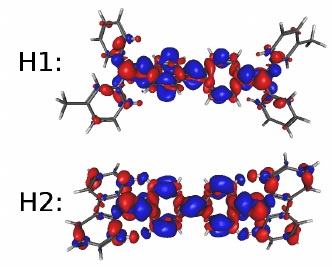
Figure 6. Iso-contour plots (cutoff value of 0.001 au.) of ground- and the first excited-state density difference for the hole-acceptor systems H1 and H2. Table 5. Charge-transfer parameters computed using the density for the main excited state (second column) of each molecule here considered (first column). Units used for the calculated magnitudes are given in parenthesis. Molecule Excited State q CT (Electron-Charge) d CT